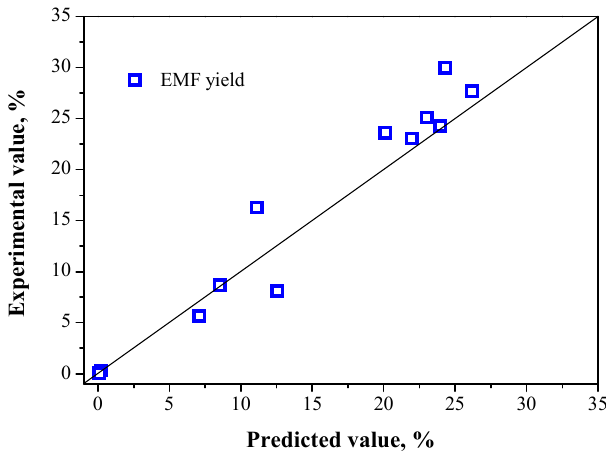
Figure 4. Relationship between the experimental and predicted EMF yield from the conversion of sucrose in ethanol medium over various metal salts. Predicted EMF yield from sucrose = (EMF yield from fructose + EMF yield from glucose)/2.